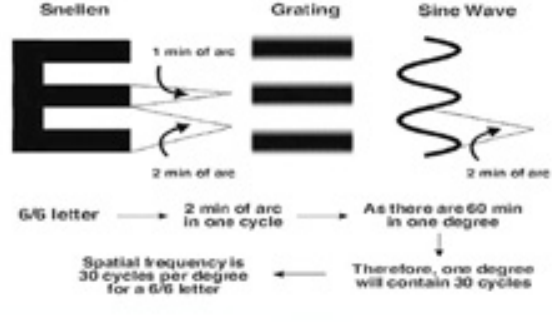
Figure 1 . Conversion of Snellen notation to spatial frequency (Figure reproduced with permission of Webvision) 5